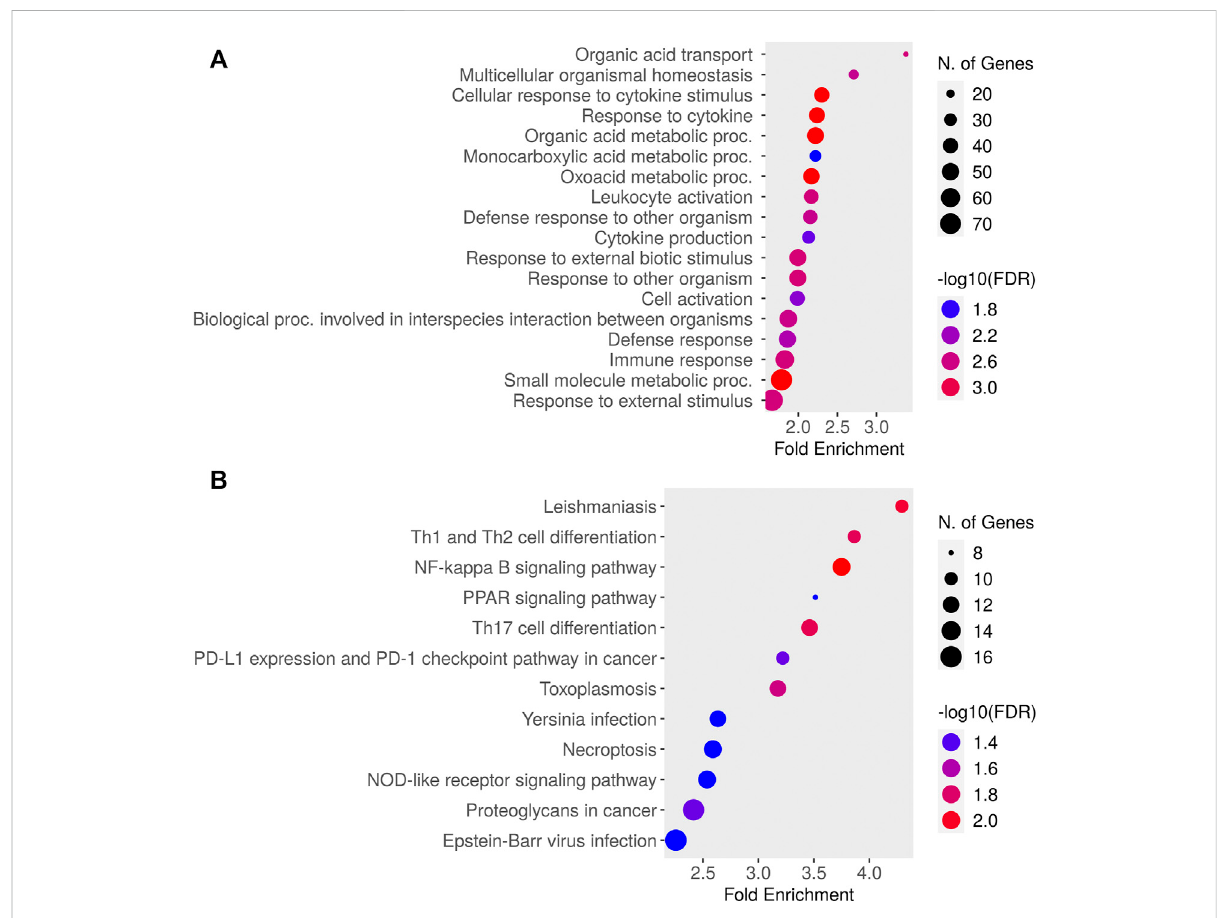
FIGURE 4 Dotplot of (A) Gene Ontology (GO) Biological Processes and (B) Kyoto Encyclopedia of Genes and Genomes (KEGG) pathways enriched for genes differentially expressed in the lactating udder at 12 h post